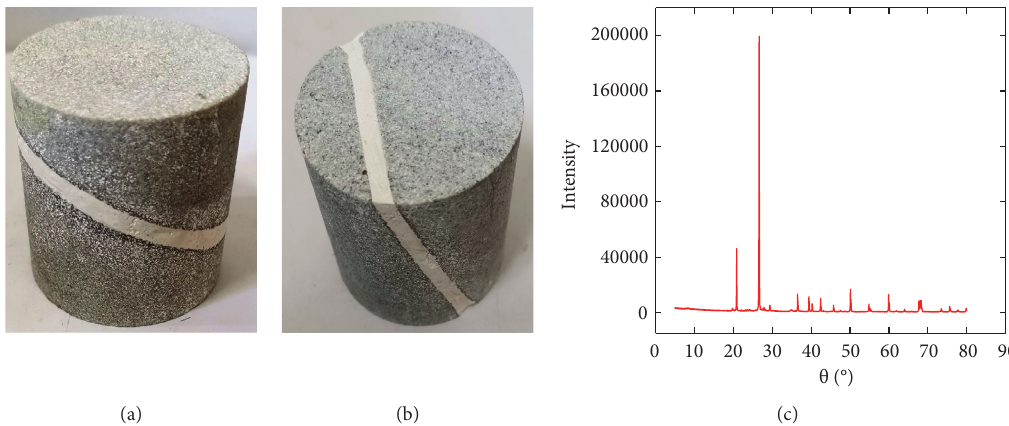
Figure 1: Physical pictures of jointed specimens and XRD diffraction pattern of sandstone. (a) Specimen with a joint angle of 30 ° . (b) Specimen with a joint angle of 60 ° . (c) XRD diffraction pattern of